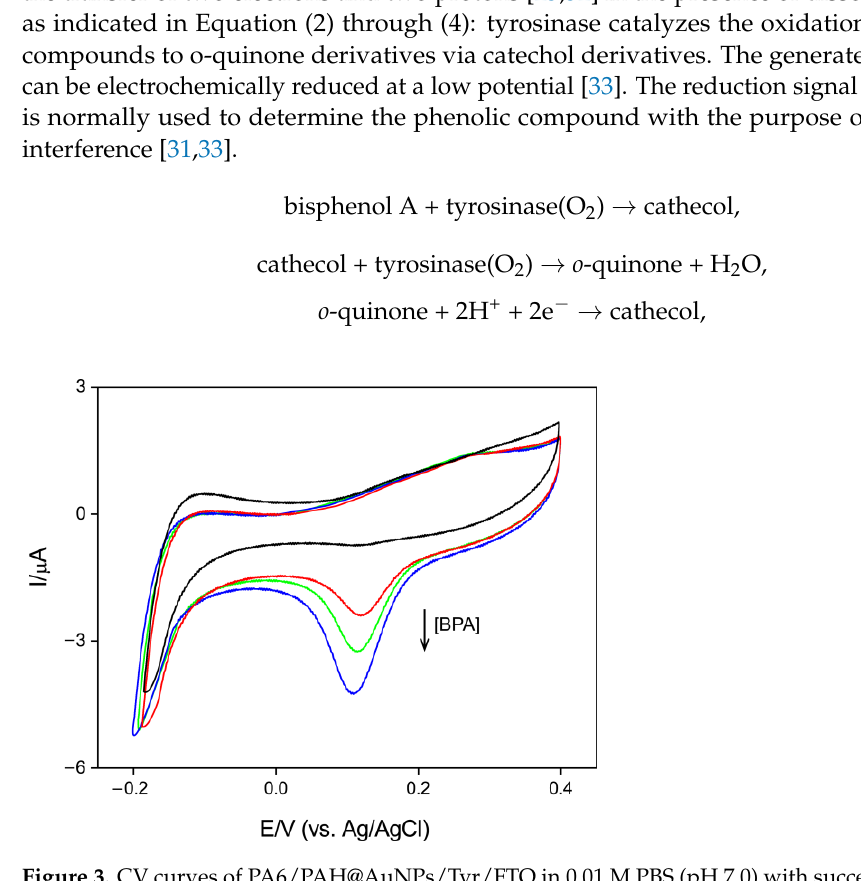
Figure 3. CV curves of PA6/PAH@AuNPs/Tyr/FTO in 0.01 M PBS (pH 7.0) with successive addition of BPA. Scan rate: 0.05 V s −1 .